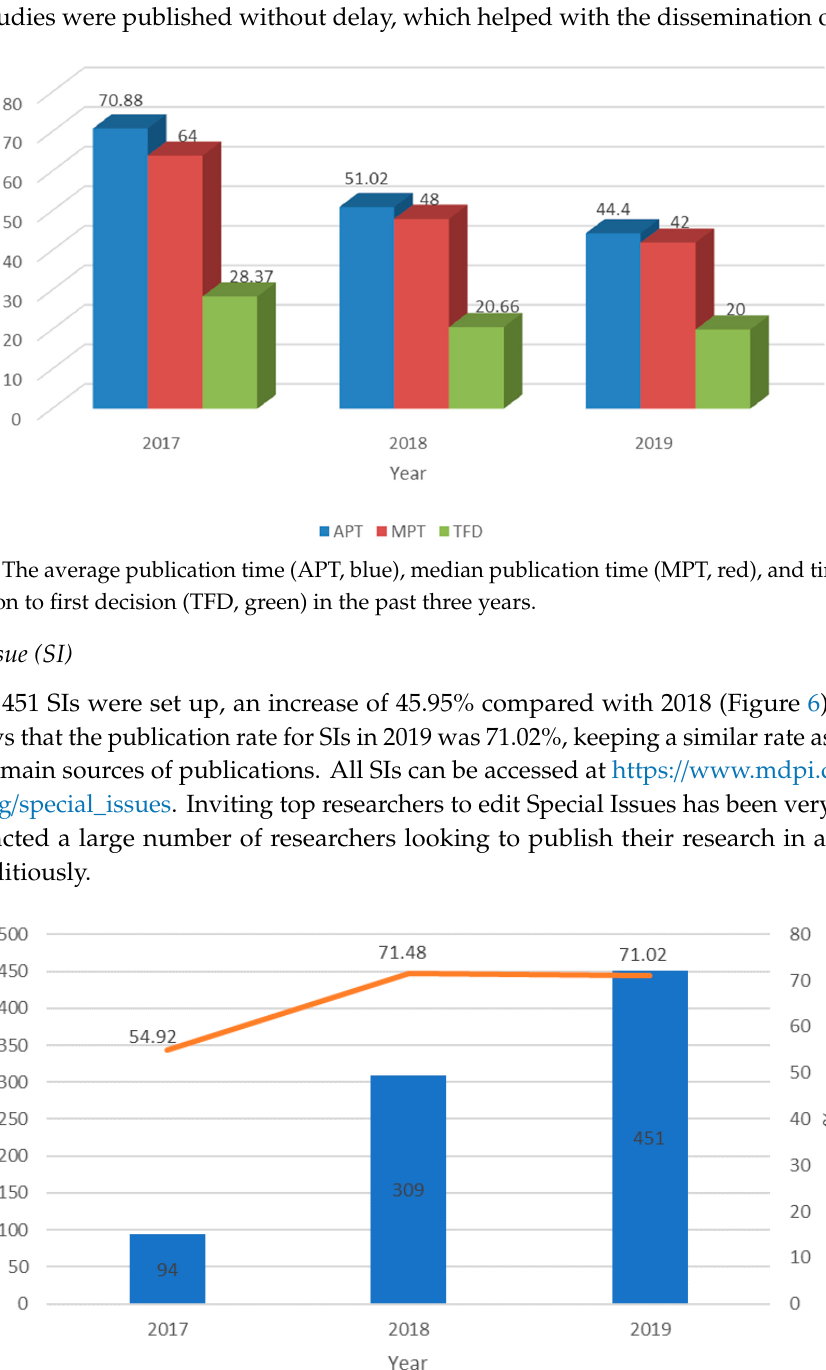
Figure 4. Top 10 countries/territories based on the percentage of author distribution in 2018 vs. 2019 for the Remote Sensing Open Access Journal of MDPI.